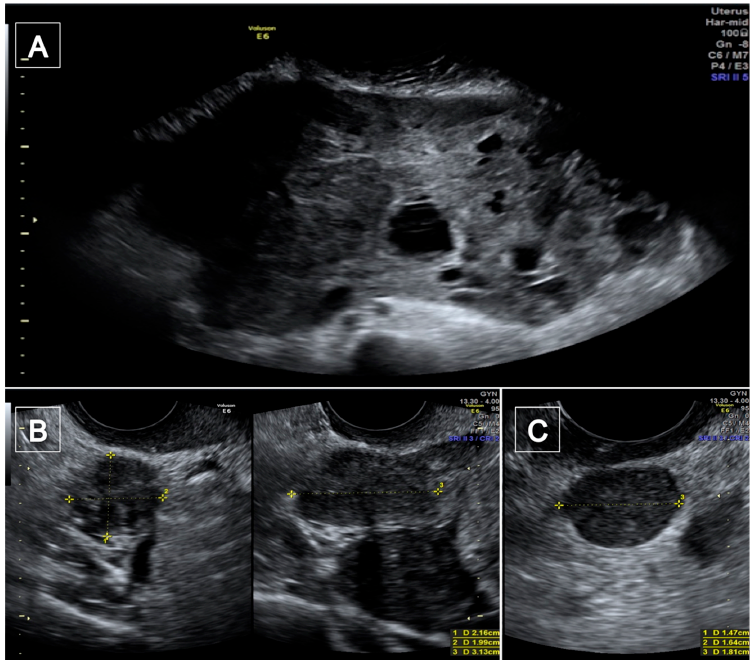
Figure 1. The trans-abdominal ultrasound examination. A voluminous mass with irregular margins and a heterogeneous echotexture for the presence of some cystic areas with anechoic content ( A ); two masses behind the uterus with regular margins, inhomogeneous echotexture and with acoustic shadows ( B ); a lesion of 14 × 16 × 18 mm with regular margins ( C ).